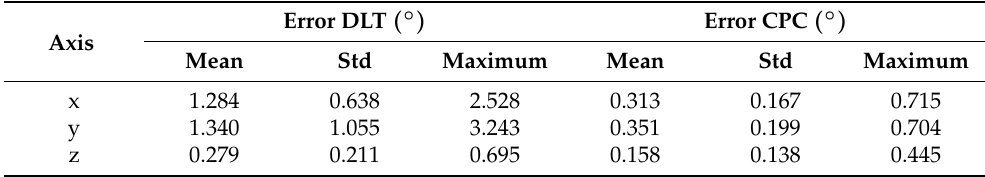
Table 2. Error values in the determination of the orientation angles using DLT and CPC.